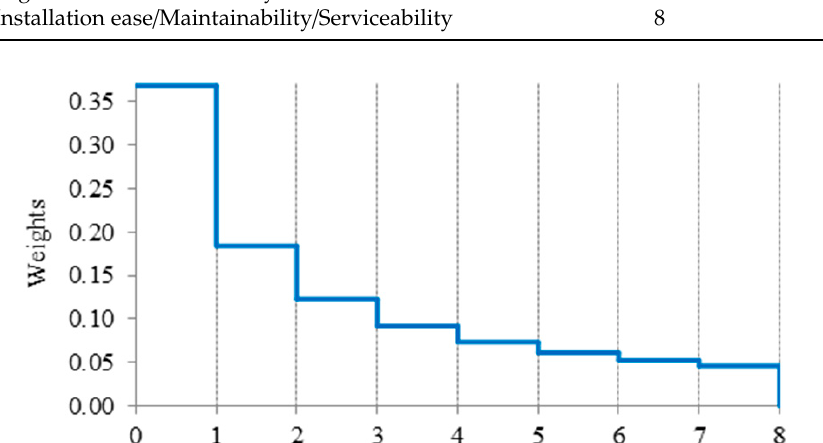
Designs 2019 , 3 , x FOR PEER REVIEW